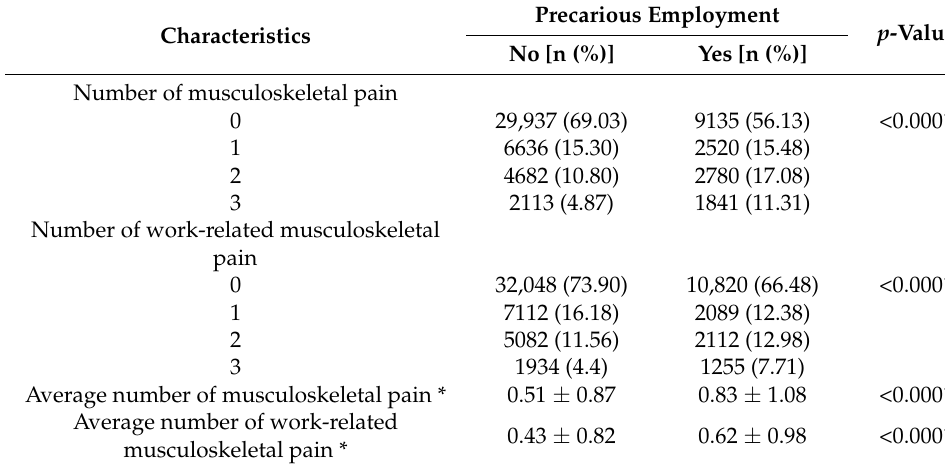
Table 2. Number of musculoskeletal pain by precarious